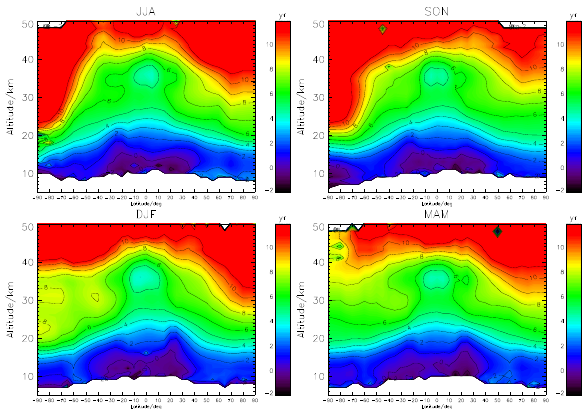
Fig.3. Zonal meandistribution of meanage of stratospheric air for the four seasons, derived by averaging Fig. 3. Zonal mean distribution of mean age of stratospheric air MIPASAoAdataofallavailableyearsfortherespectiveseason. for the four seasons, derived by averaging MIPAS AoA data of all available years for the respective